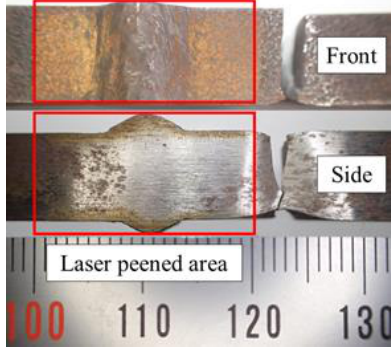
Figure 16. Photo of specimen after fatigue test.